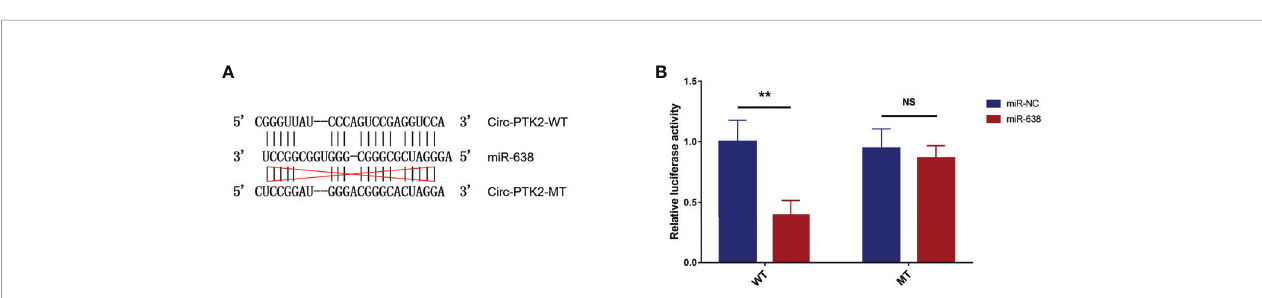
FIGURE 4 | Circ-PTK2 reversely regulated miR-638. The effect of circ-PTK2 overexpression plasmid transfection on miR-638 (A) , miR-4690 (B) , miR-6724 (C) , miR-6749 (D) and miR-6775 (E) was detected by RT-qPCR in U226 cells. The effect of circ-PTK2 knock-out plasmid transfection on miR-638 (F) , miR-4690 (G) , miR-6724 (H) , miR-6749 (I) and miR-6775 (J) was detected by RT-qPCR in LP-1 cells. Circ-PTK2, circular RNA protein tyrosine kinase 2; miR, micro RNA; NS, non-signi fi cant; RT-qPCR, reverse transcription quantitative polymerase chain reaction; OE-circ-NC, circRNA control overexpression; OE-circ-PTK2, circ-PTK2 overexpression; KD-circ-NC, circRNA control knock-down; KD-circ-PTK2, circ-PTK2 knock-down; * P < 0.05; ** P < 0.01. RNA expression was normalized by 2 - △△ Ct method. Experiments were performed in triplicates. The comparison was determined by One-way ANOVA followed by Dunnett ’ s multiple comparison test.